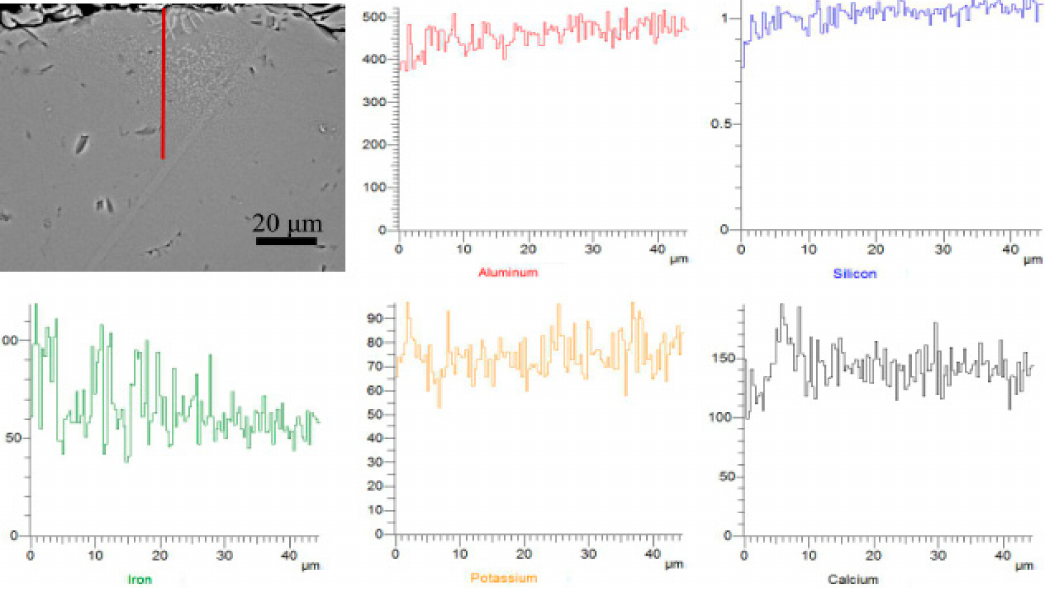
Figure 8. The element map distribution results of the polished cross-section (Al, Si, Fe, K, and